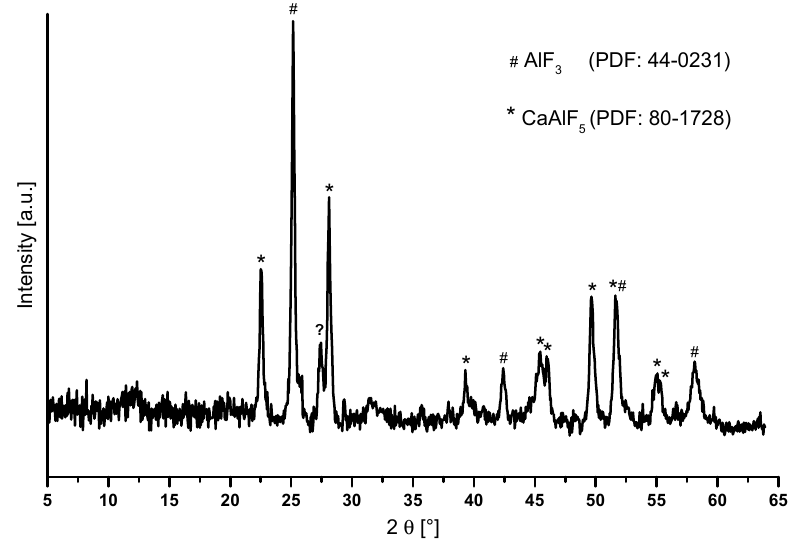
Figure 9. Powder diffractogram of the annealed nominal “CaAl 2 F 8 ” xerogel at 700 ° C for two minutes with reflections of CaAlF 5 and AlF 3 .